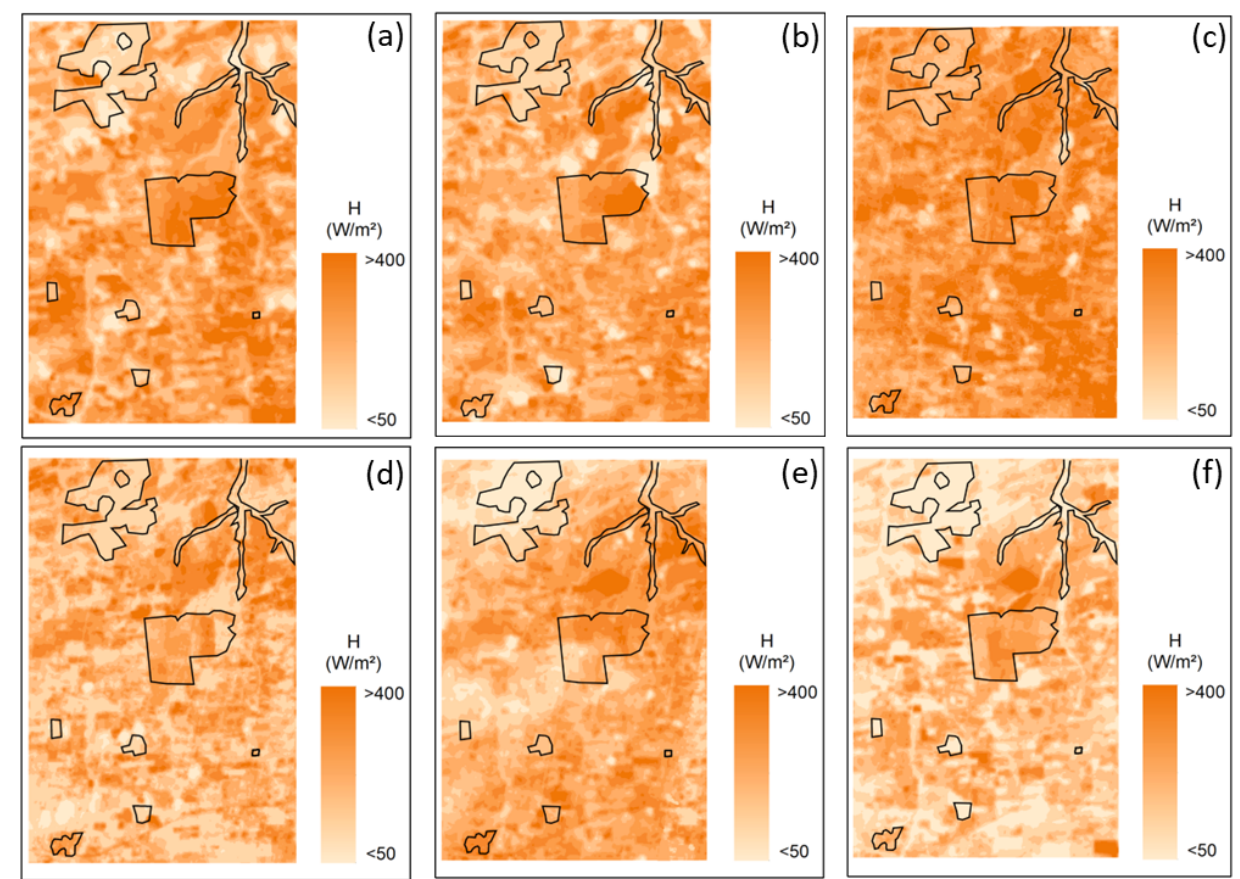
Figure 8. Temporal distribution of the sensitive heat flow (H) on 20 November 2017 ( a ), 22 December 2017 ( b ), 31 May 2018 ( c ), 7 June 2018 ( d ), 26 June 2019 ( e ), and 29 August 2019 ( f ). The daily evapotranspiration estimates over the period evaluated are presented in Figure 10. It was observed that in relation to heterogeneous soils the distribution of the daily value of ET was well distinguished by the model, with an average value for the scene of 3.64 mm day − 1 on 20 November 2017 (Figure 10a). At the point where the micrometeorological tower was located, the ET estimated by SEBAL on this day was 4.16 mm day − 1 . In areas of surfaces covered with vegetation, it was observed that the ET was higher, reaching up to 6.45 mm in some areas, which also had high NDVI (>0.5) and low temperatures (Figure 7). The highest values of evapotranspiration were in areas with vegetal covering, namely, permanent preservation areas (APP) and fragments of dense vegetation (Figure 10b), as observed on 22 December 2017. On 31 May 2018, the mean ET value was 3.28 mm day − 1 (Figure 10c) and the estimated ET in the açaí planting area was 4.39 mm day − 1 . The average value of ET on 7 June 2018 was 4.00 mm day − 1 , and at the site referring to the micrometeorological tower it was 4.47 mm day − 1 (Figure 10d). On 26 June 2019, in areas with low vegetation the ET values were between 2.04 and 2.95 mm day − 1 , and the lowest estimates were in exposed soil areas (Figure 10e). On this day, the evapotranspiration value estimated in the açaí planting area was 4.13 mm day − 1 . Among all periods evaluated, the scene obtained from 29 August 2019 indicated a day with more available energy (Figure 6f) and latent flux (Figure 9f), and the evapotranspiration value in the açaí plantation was 4.49 mm day − 1 (Figure 10f), while the average obtained for the analyzed scene was 4.14 mm day − 1